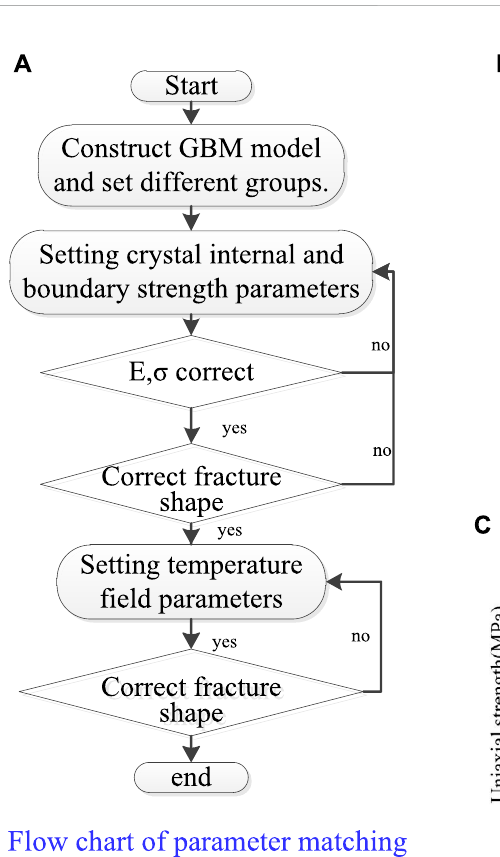
TABLE 3 PFC meso